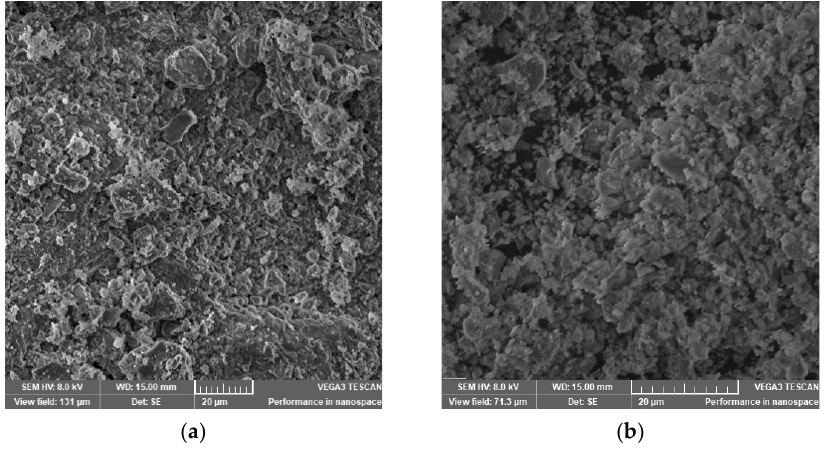
Figure 2. SEM images of ( a ) NZ1 and ( b ) NZ2 . Table 2. Physical and chemical composition (% w/w ) of zeolites used in the experiments (mean ± standard deviation, n = 3) .